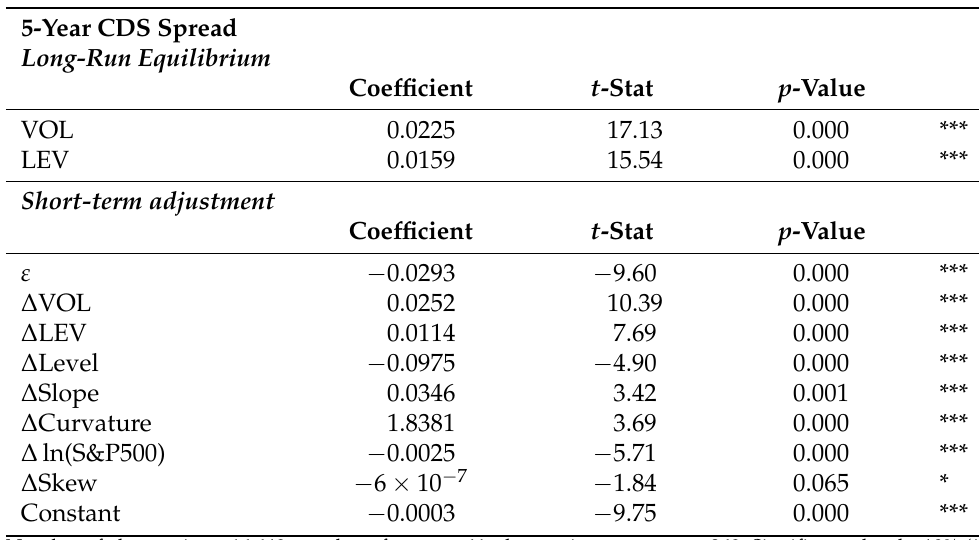
Table 7. ECM for 5-year CDS spreads. All the variables which structural models predict to influence the change in spreads are statistically significant and have the predicted signs. The loading on the cointegrating equation ( ε ) is negative and statistically significant, thus confirming the existence of a long-term equilibrium to which spreads, volatility and leverage converge. This model constrains the long-run coefficient vector to be equal across panels while allowing for group-specific short-run and adjustment coefficients. The averaged short-run parameter estimates are